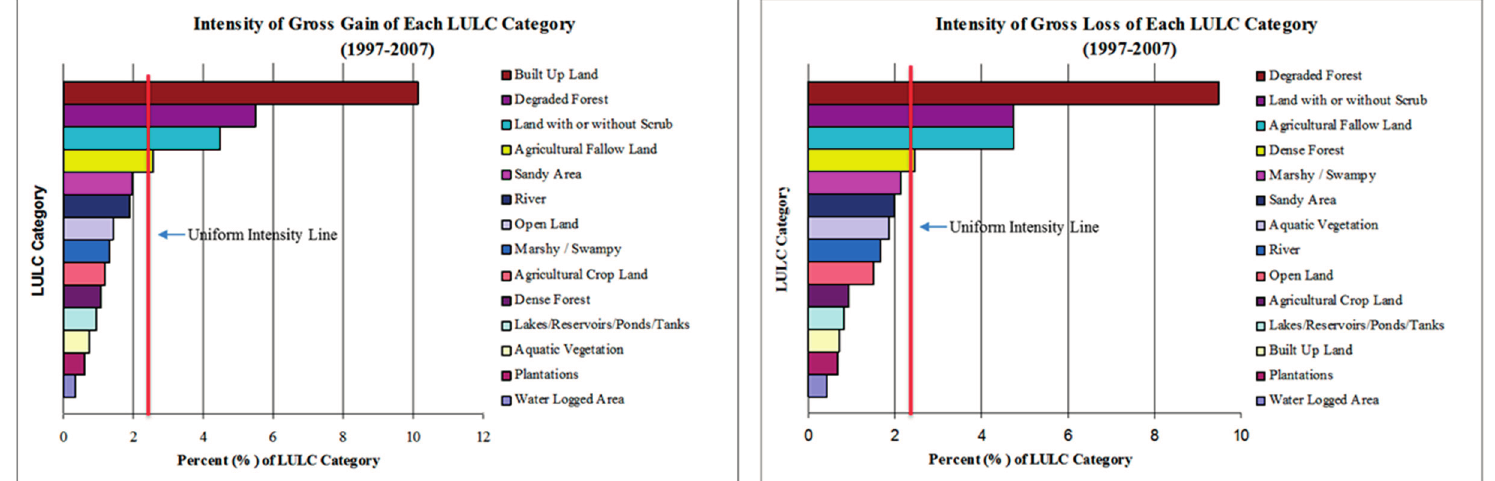
Figure 8. Intensity of gross gain and gross loss of each LULC category in between 1997 and